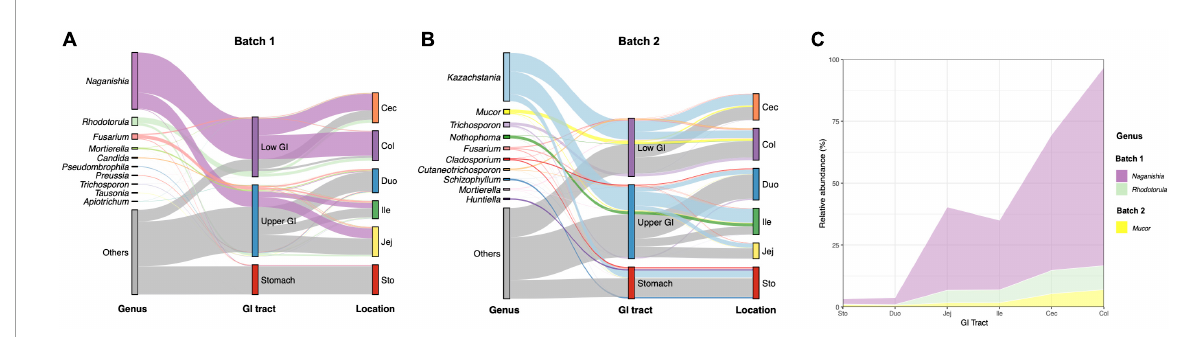
FIGURE3 Variations of fungal composition in different regions of the gastrointestinal tract at the genus level. Relative abundance of the top 10 abundant genera over intestinal segments (stomach, duodenum, jejunum, ileum, cecum, and colon) are aggregated and colored on a Sankey-stream graph. (A) Batch 1, (B) Batch 2. Low abundance taxa (except for the 10 most abundant genera) are grouped together as “others”. Lines represent associations between indicator genera and intestinal segments, colored by genus taxa. The line width is scaled to reflect the relative abundance. (C) Trends in mean relative abundances of significant fungi along the GIT of growing-finishing pigs from two